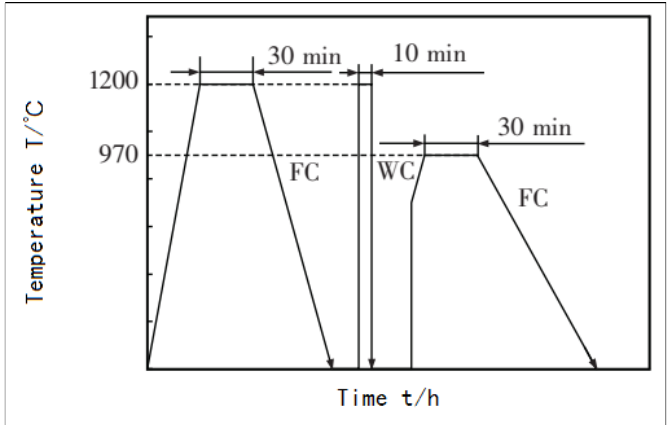
Figure 15. Heat treatment process.